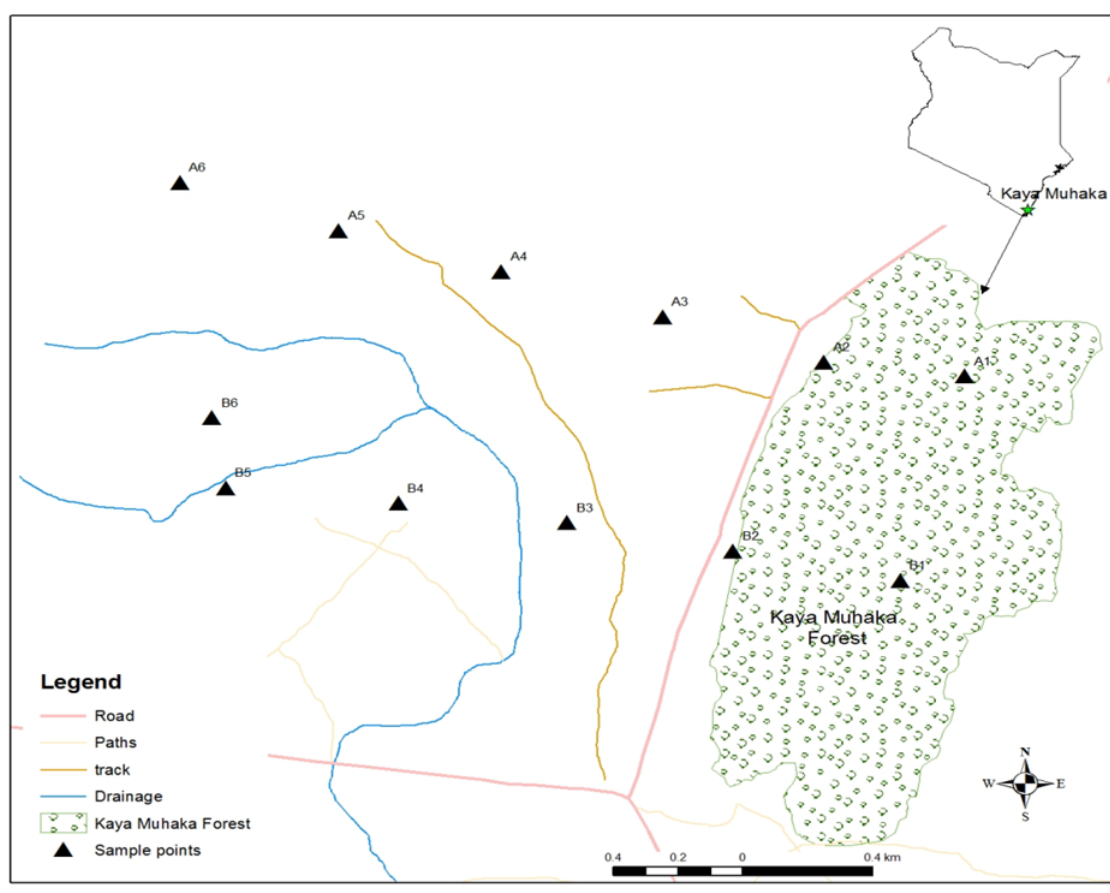
F IGURE 1: Study area and satellite map of sampling